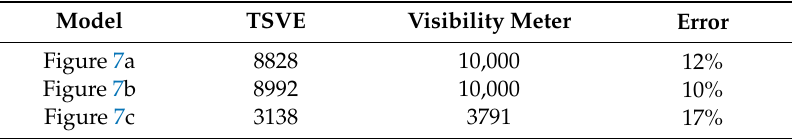
Figure 7. Images grabbed on the validation site with cars and pedestrians on the road. ( a ) cars and pedestrians; ( b ) pedestrians; ( c ) pedestrian with an umbrella. pedestrians; ( b ) pedestrians; ( c ) pedestrian with an umbrella. Table 3. Visibility estimation results of the images in Figure Table 3. Visibility estimation results of the images in Figure 7.